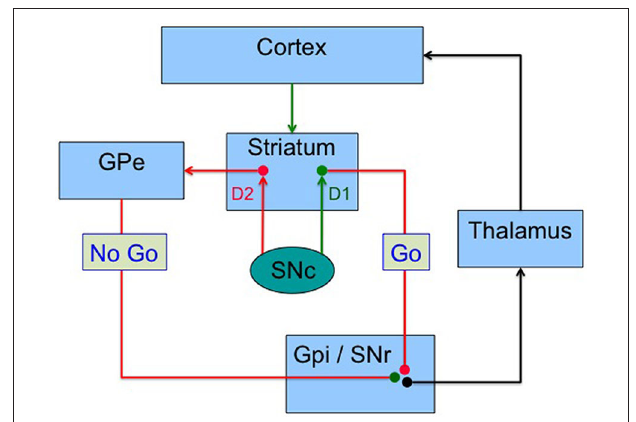
FIGURE 2 | Basal ganglia model. A possible model whereby basal ganglia compute the utility of gains and losses via two segregated pathways in the corticostriato-thalamocortical circuit. Striatal output neurons of the direct pathway express D1 receptors and project to the internal globus pallidus (GPi) and the substantia nigra pars reticulata (SNr), and has an action selection effect on cerebral cortex. Striatal output neurons in the indirect pathway express D2 receptors and reduce the tonic inhibition of the external globus pallidus (GPe) on the GPi/SNr, which leads to action inhibition in the cortex. D1 receptors respond mainly to phasic (high concentration) dopamine signaling due to their low affinity for dopamine. D2 receptors have high affinity for dopamine and respond to lower tonic dopamine levels. Excitatory projections in green, inhibitory in